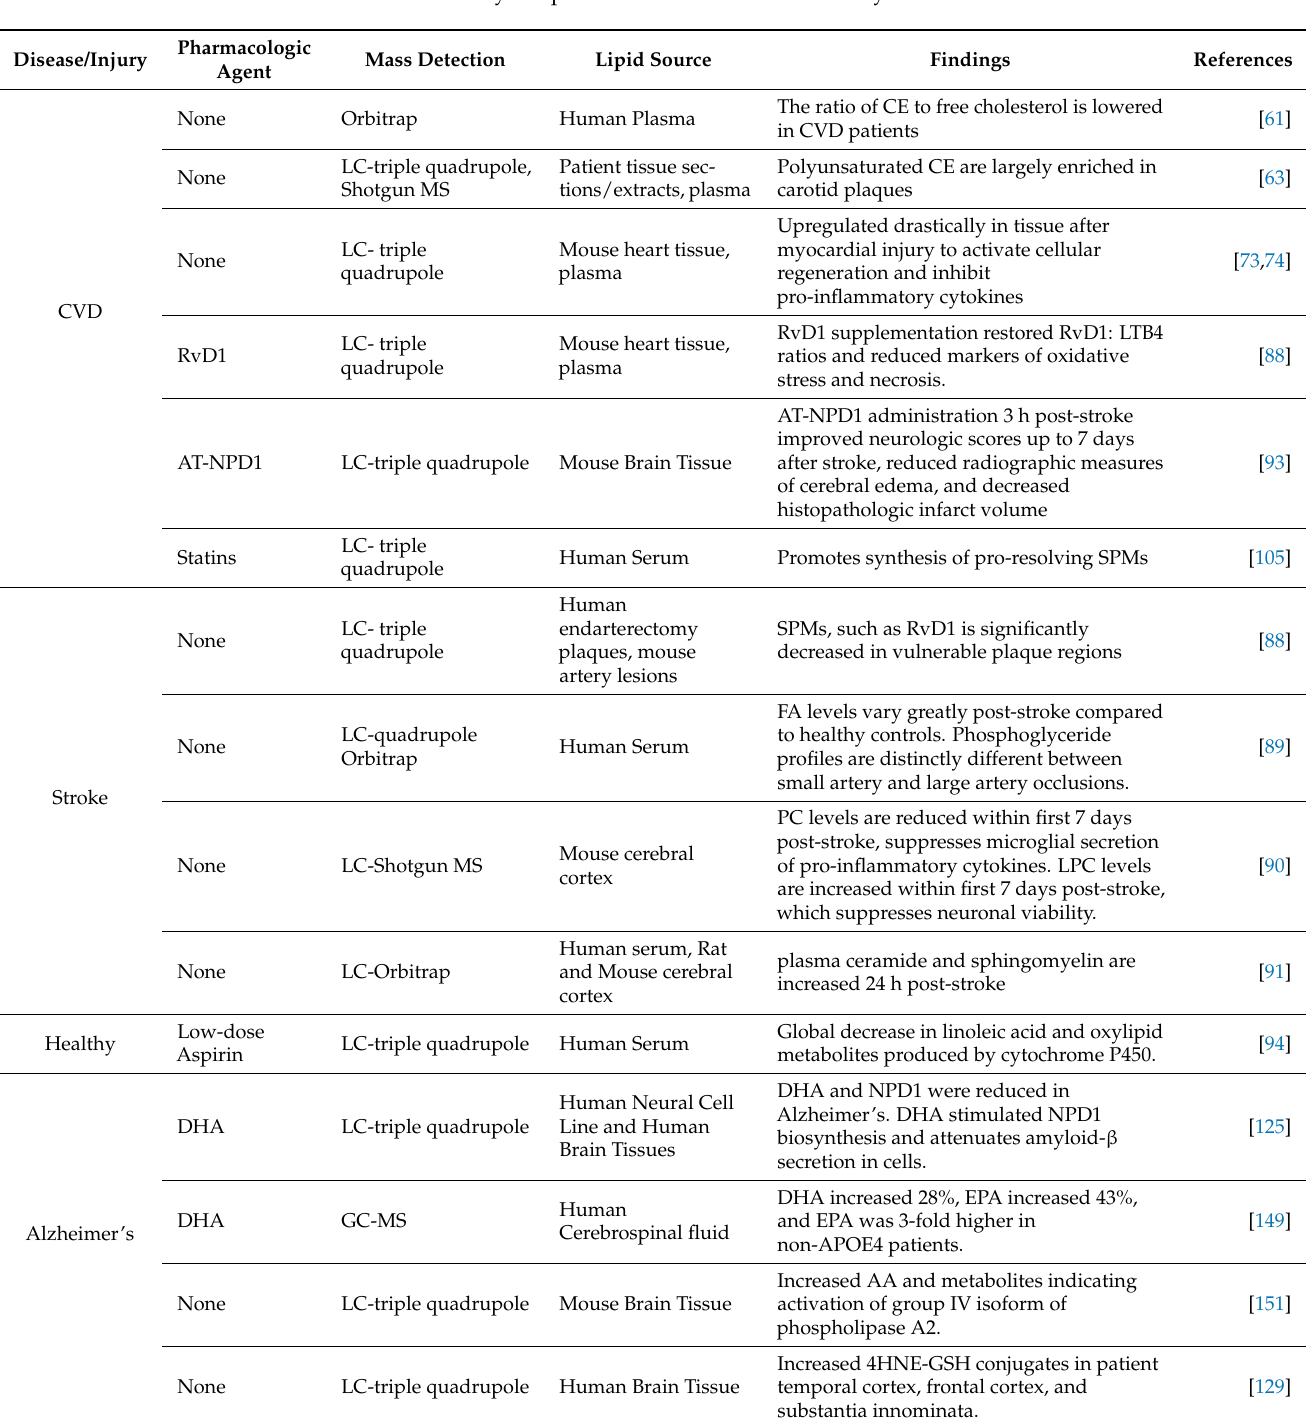
Table 2. Summary of lipidomics studies in inflammatory disease